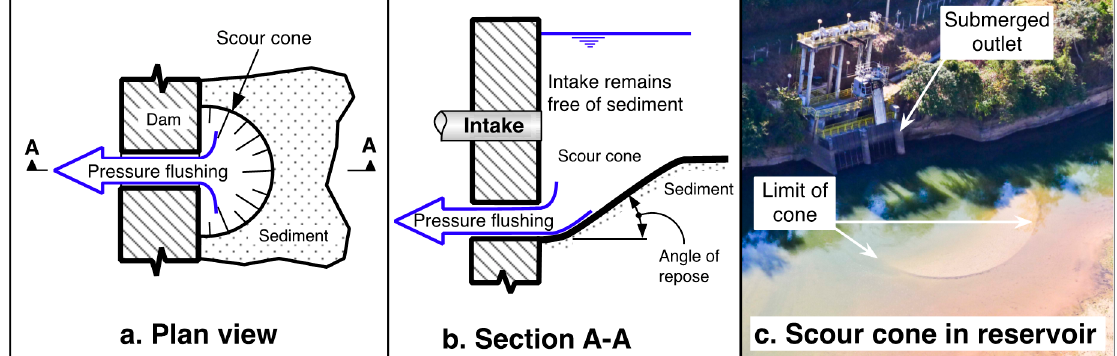
Figure 10. ( a ) and ( b ) Pressure flushing scour cone configuration based on physical modeling Figure 10. ( a , b ) Pressure flushing scour cone configuration based on physical modeling (modified (modified from [65]). ( c ) Scour cone at outlet of sedimented reservoir on Río San Antonio, Minas, from [65]). ( c ) Scour cone at outlet of sedimented reservoir on R í o San Antonio, Minas, Gerais, Brazil. Gerais, Brazil. (photo by author). (photo by